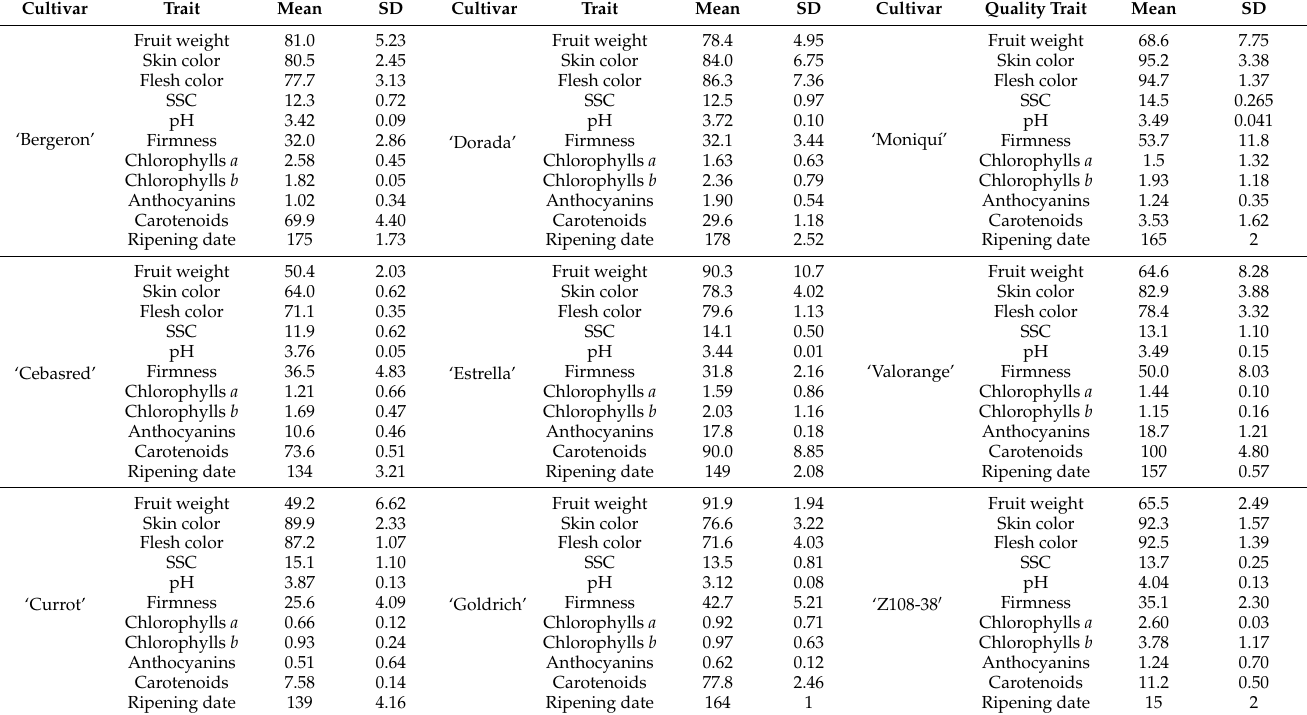
Table 1. Descriptive statistics (mean and standard deviation (SD)) of phenological ripening date and quality traits (fruit weight, skin color, flesh color, soluble solids content (SSC), acidity (pH), firmness, chlorophyll a , chlorophyll b, anthocyanins and carotenoids content) analyzed in nine apricot cultivar cultivars ‘Bergeron’, ‘Cebasred’, ‘Currot’, ‘Dorada’, ‘Estrella’, ‘Goldrich’, ‘Moniqu í ’, ‘Valorange’ and ‘Z 108-38 (cid:48) at physiological